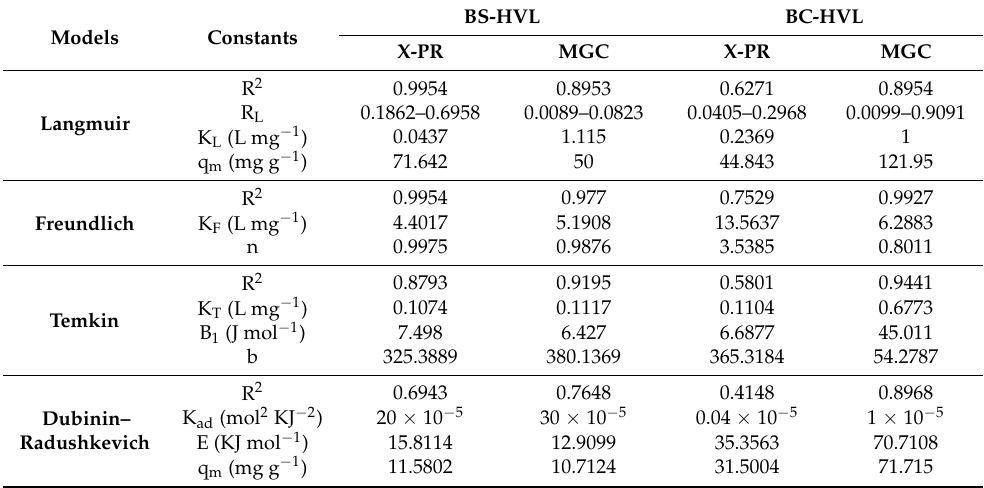
Table 2. Adsorption isotherms constants of X-PR and MGC on BS-HVL and BC-HVL (T = 21 ± 1 ◦